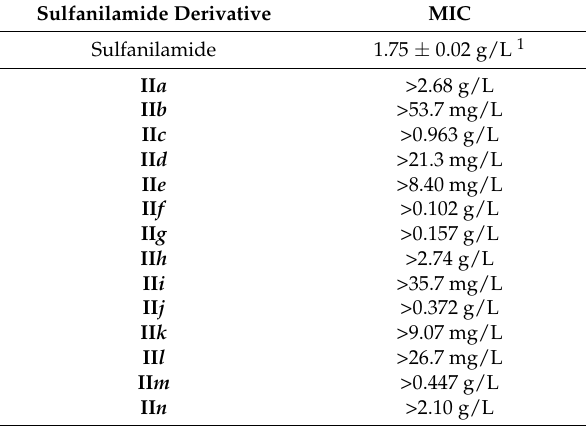
Table 3. MIC values of sulfanilamide and its derivatives for the P. aeruginosa antibiotic-resistant strain